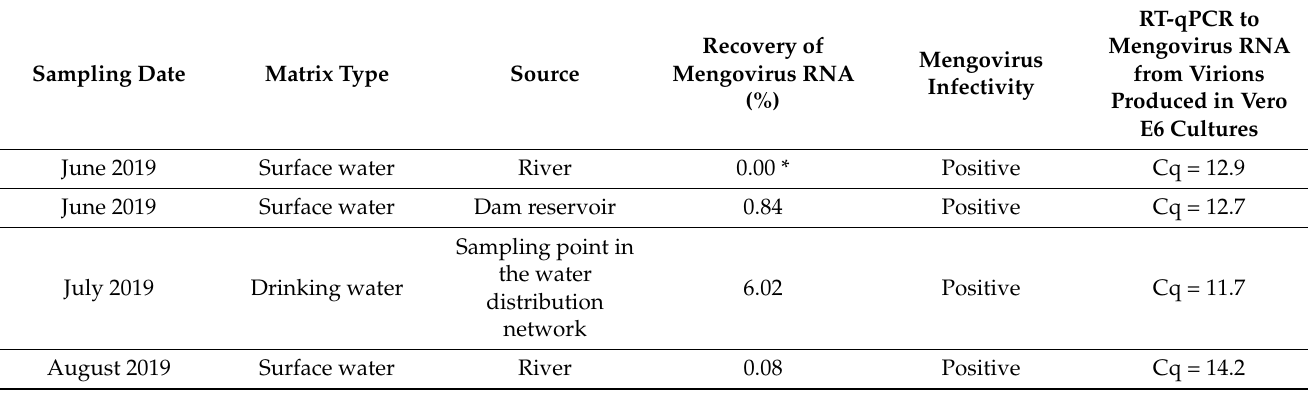
Table 3. Data regarding the samples assayed for mengovirus